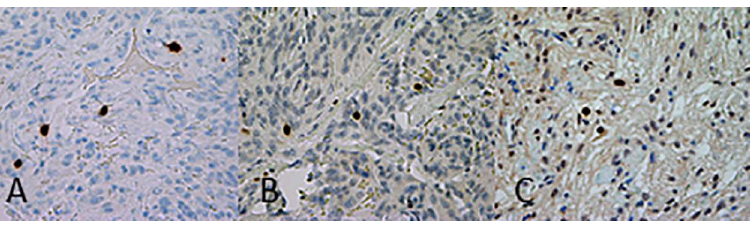
Fig 1. Immunostaining of proliferation markers. Examples of MIB-1 immunostaining (A), topoisomerase II α immunostaining (B), and mitosin immunostaining (C) of meningioma (magnification 400 × ).The staining intensity was more homogenousand distinct for topoisomerase II α and mitosin than for